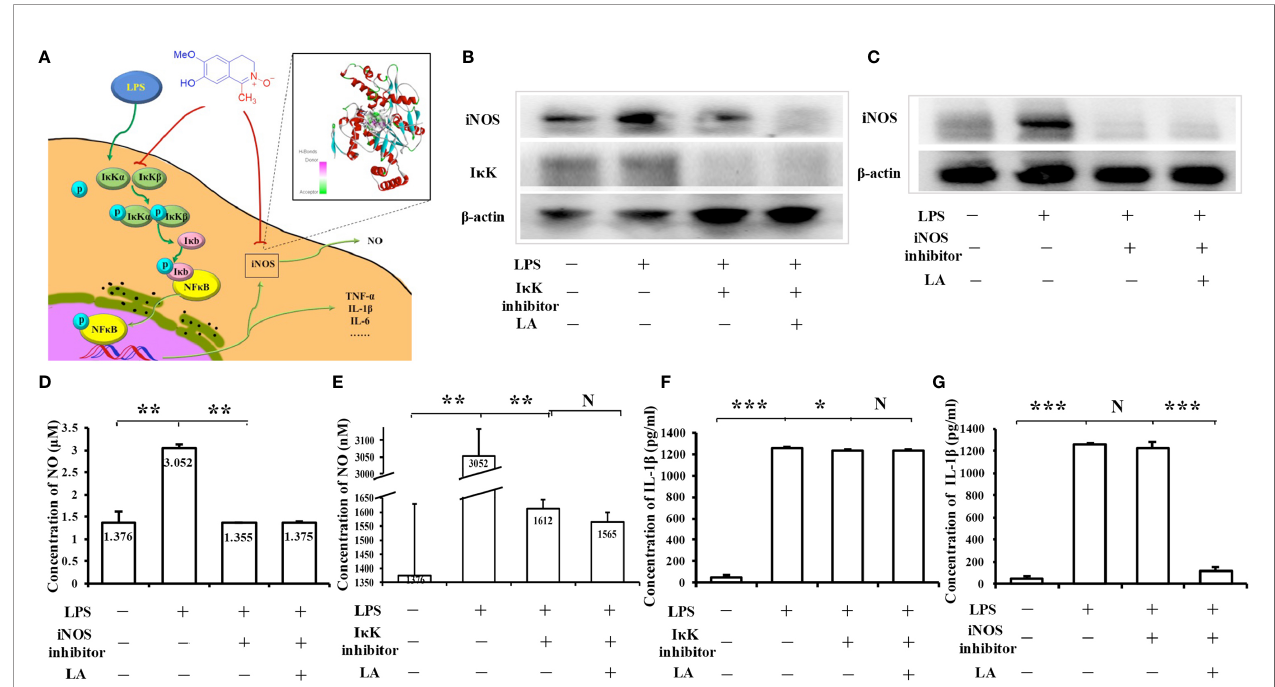
FIGURE 8 | The anti-in fl ammatory effect of LA is achieved by inhibiting both the NF- k B pathway and the activity of iNOS protein (A) Scheme based on the results of this study showing that LA inhibits the LPS-induced macrophages by both the NF- k B pathway and the downstream product iNOS protein. (B) Western blot showing that an I k K inhibitor effectively suppresses the expression level of I k K in RAW264.7 macrophages. Moreover, when the NF- k B pathway was blocked with an I k K inhibitor, the expression of downstream iNOS protein induced by LPS was decreased. However, the expression of iNOS could be further inhibited by treatment with LPS + LA compared to LPS only, proving that LA can speci fi cally inhibit iNOS protein. (C) Western blot showing that an iNOS inhibitor effectively suppressed the expression level of iNOS in RAW264.7 macrophages. (D) NO levels were signi fi cantly reduced after treatment with an iNOS inhibitor, which was not affected by treatment with additional LA under such conditions (n=3). (E) When the NF- k B pathway was blocked with an I k K inhibitor, NO production was inhibited and could be further decreased by treatment with additional LA (n=3). (F) ELISA analysis showing that when the upstream NF- k B pathway was blocked with an I k K inhibitor, the expression of IL-1 b induced by LPS was decreased, and this was not affected by further treatment with LA (n=3). (G) When iNOS activity was blocked by an iNOS inhibitor, the expression of IL-1 b remained stable, but the additional treatment with LA signi fi cantly inhibited the expression of IL-1 b induced by LPS (n=3). All results are representative of at least three independent experiments/samples. Results are expressed as means ± standard deviation (SD), and statistical signi fi cance is shown as N P > 0.05, **P < 0.01, ***P <